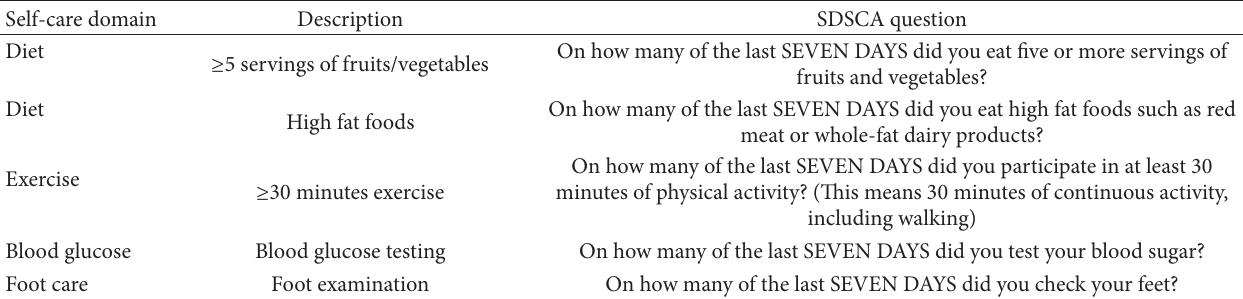
Figure 1: The Pathways Study subject recruitment. Table 1: Selected questions from the Summary of Diabetes Self-Care Activities